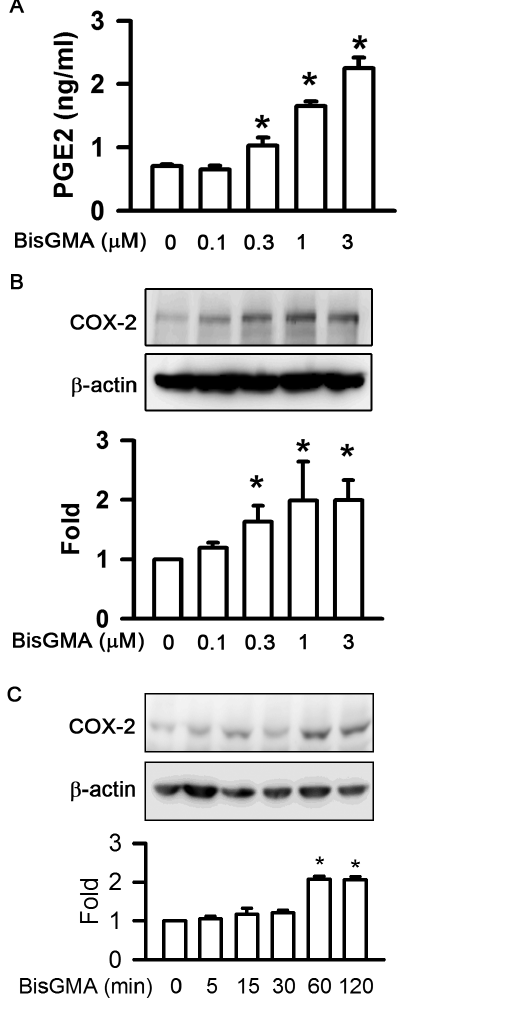
Figure 2. Effects of BisGMA on the expression of PGE2 and COX-2. (A) RAW264.7 macrophages were stimulated with the indicated concentrations of BisGMA for 2 h. The supernatant was harvested and detected by ELISA assay of PGE2. Values are expressed as mean 6 SD (n=3). *represents significant difference from control values with p , 0.05. (B) Cells were exposed to the indicated concentrations of BisGMA for 2 h. Cells were harvested and protein extracts were subjected to SDS-PAGE. Values are expressed as mean 6 SD (n=3). The ratio of immunointensity between the COX-2 and b -actin was calculated. *represents significant difference from control values with p , 0.05. (C) Cells were stimulated with 3 m M BisGMA for the indicated treatment periods. Cells were harvested and protein extracts were subjected to SDS-PAGE. Western blot analysis using antibodies against COX-2 and b -actin. Values are expressed as mean 6 SD (n=3). The ratio of immunointensity between the COX-2 and b -actin was calculated. *represents significant difference from control values with p , 0.05.